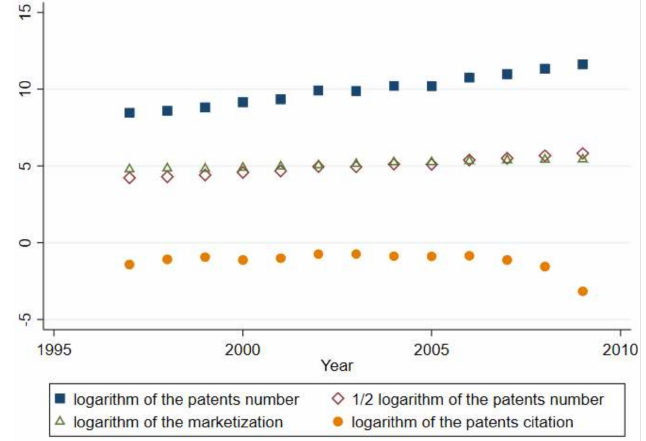
Figure 3. Marketization index logarithm and technical variable logarithmic time trend